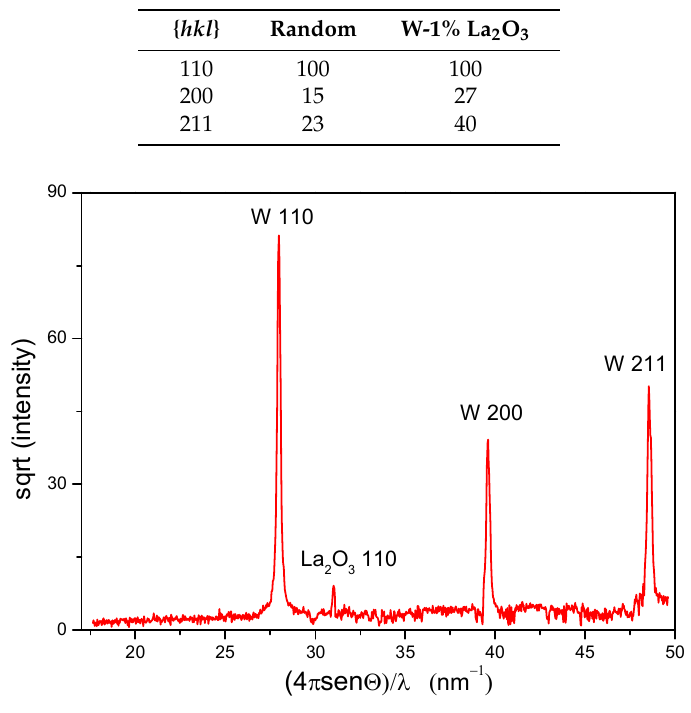
Table 2. Comparison between the relative intensities of main reflections of W-1% La 2 O 3 and those of W with random oriented grains.